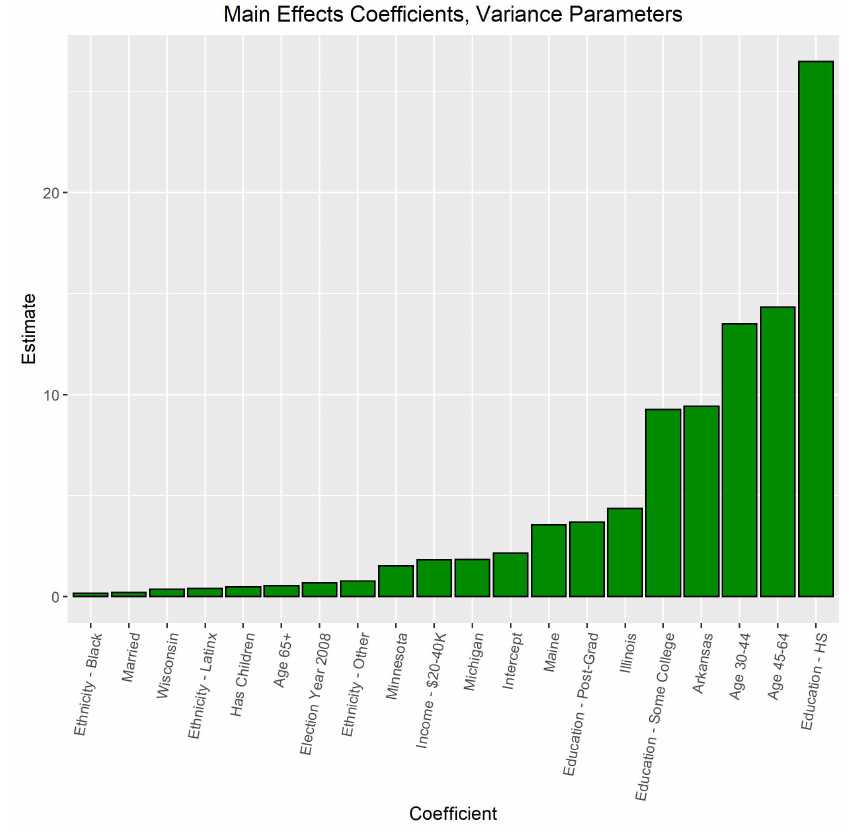
Figure 4. Selected Variance Parameters, Main